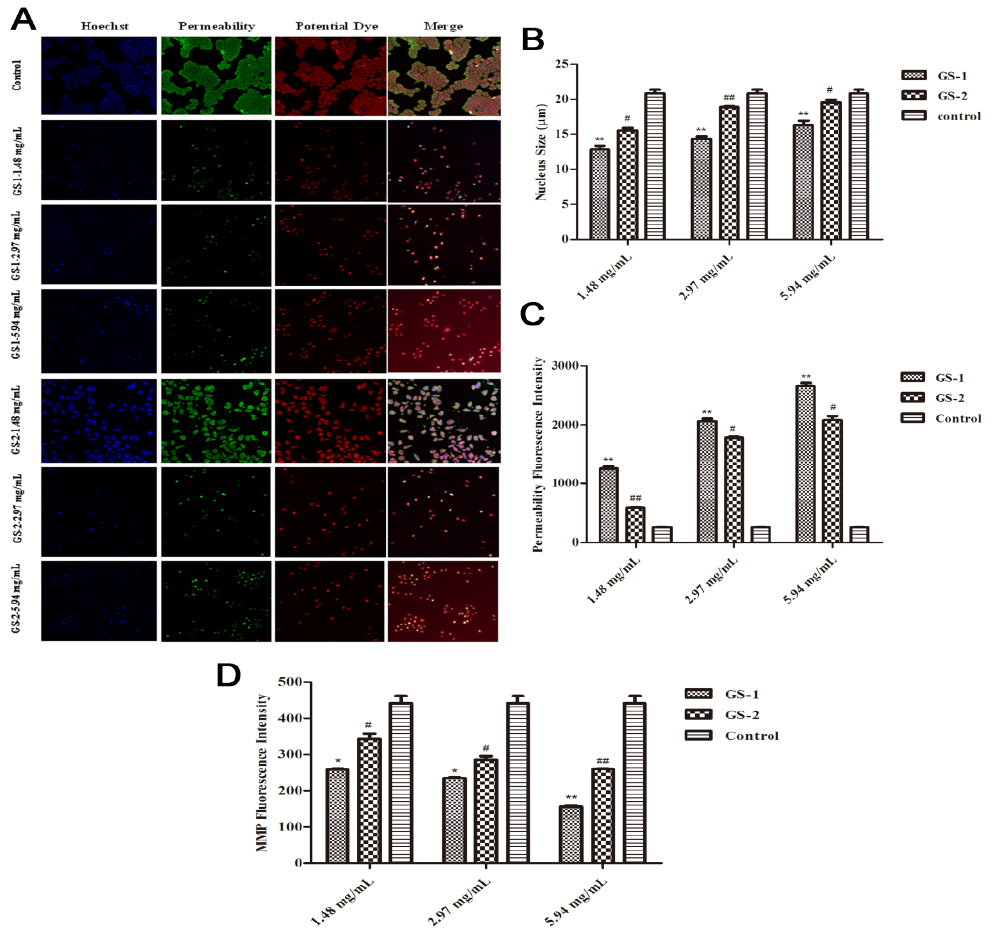
Figure 3. Effects of LO2 cells treated with GS-1 and GS-2 on mitochondrial pathway of apoptosis at the concentration of 1.48, 2.97, 5.94 mg/mL for 48 h and then fixed and stained with the Mutiparameter Cytotoxicity 3 kit, respectively. ( A ) Images of cells were taken by the high content screening (HCS) Assay Scan VTI Reader (×100). ( B ) The average cell nuclear size was quantified and analyzed by the HCS Assay Scan software. ( C ) The cell membrane permeability was reflected by the average intensity of fluorescent dyes permeabilized through cell membranes. ( D ) The cell mitochondrial membrane potential was reflected by the average intensity of mitochondrial membrane potential fluorescent dyes. Values expressed as mean ± SD from three independent experiments, * p < 0.05;